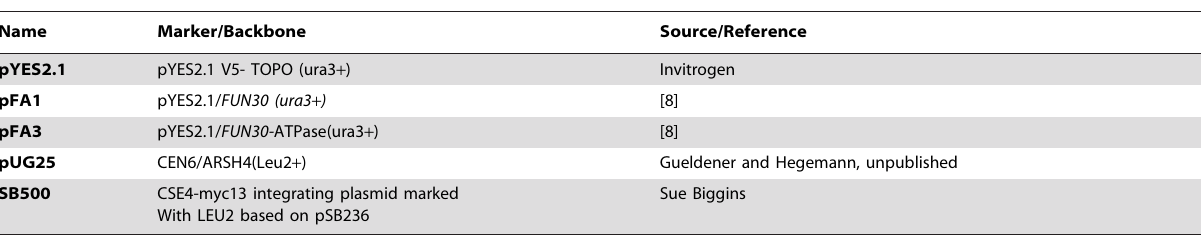
Table 2. Plasmids used in this study.